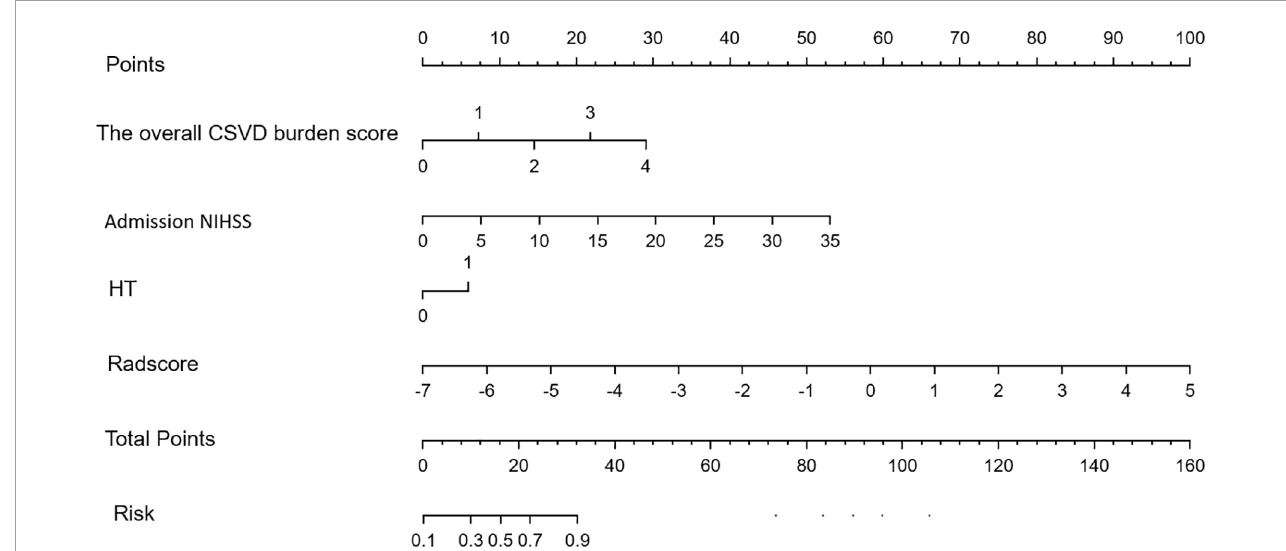
FIGURE4 Radiomics nomogram for predicting the clinical functional outcome of ischaemic